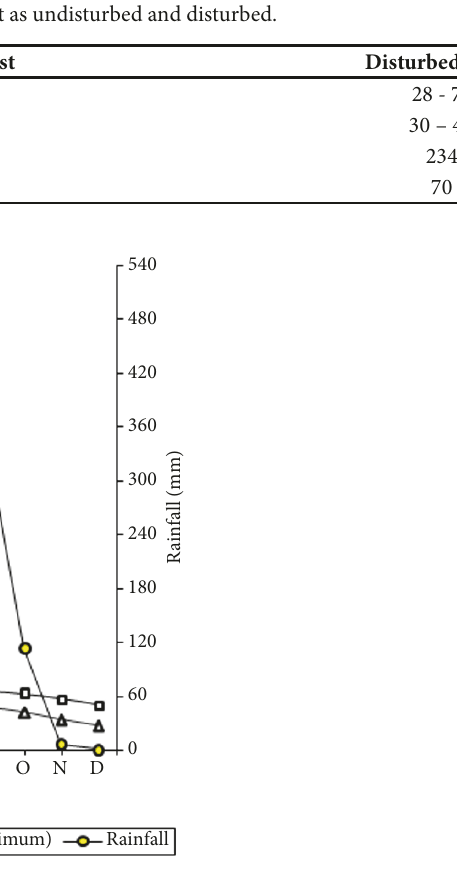
Figure 2: Ombrothermic representation of the climate of moist tropical forest region of Sunsari district, eastern Nepal. The data pertain to the period 2005–2014 (source: Department of Meteorology,